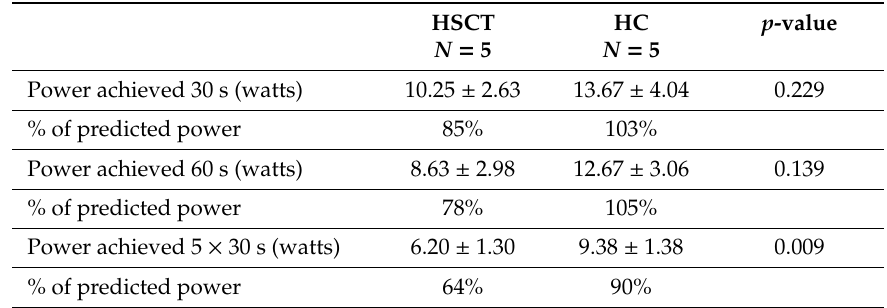
Table 3. MRI exercise power results.